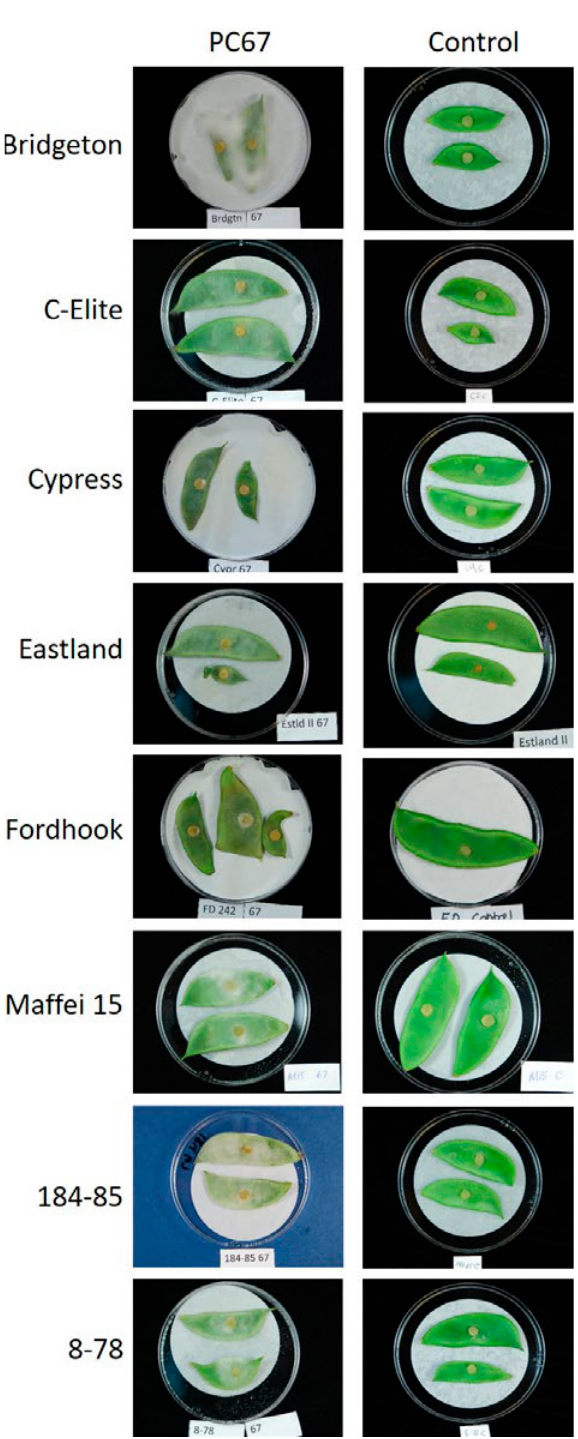
Figure 1. Lima bean pod assay. Pathogenicity testing of Phytoph- thora capsici isolate 67 on lima bean pods from eight different culti- vars. Isolate 67 inoculations resulted in sporulation on all eight cul- tivars, representative of all of other isolate reactions with the lima bean cultivars. Pods were photographed 5 d post inoculation. The experiment was repeated once, with similar